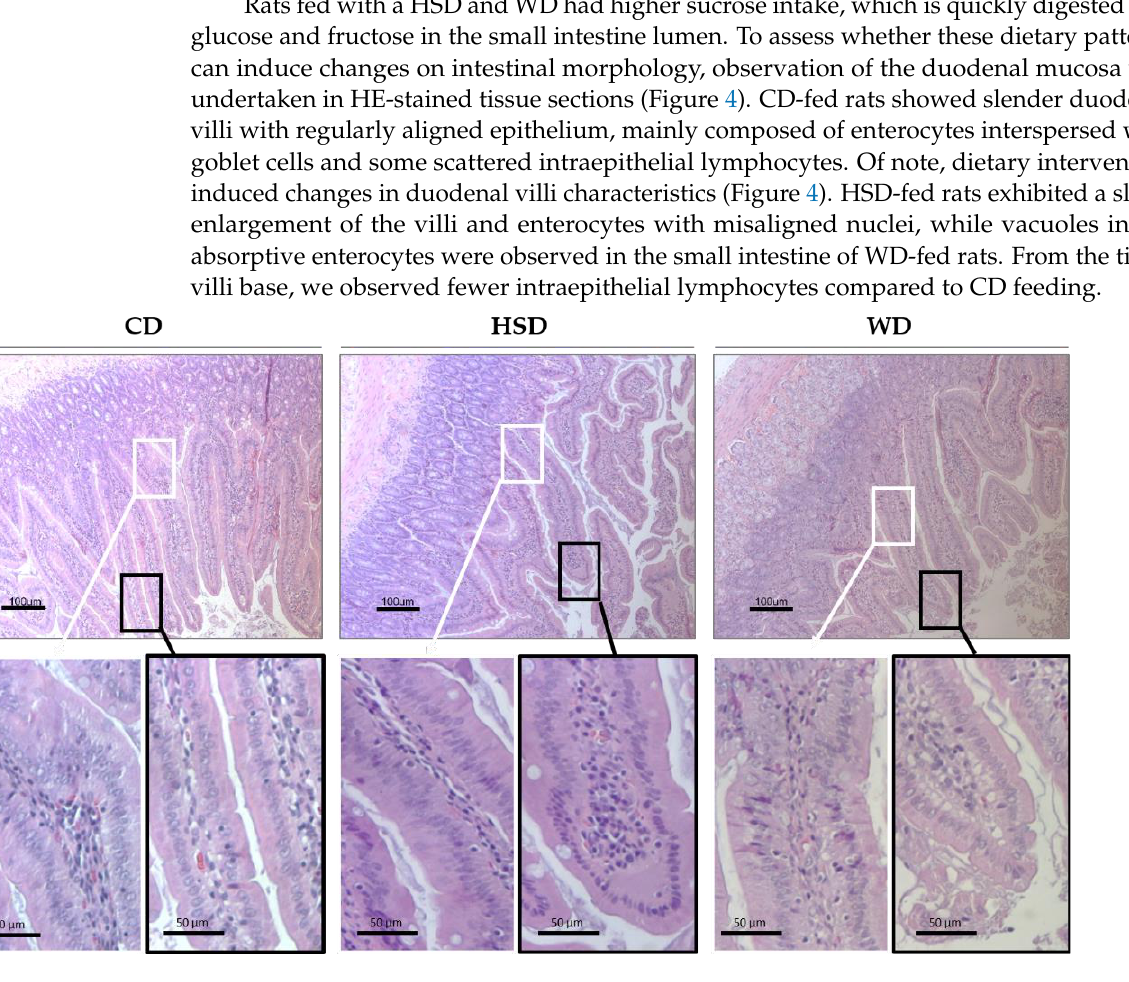
Figure 4. Dietary effects on the small intestine. Representative images of HE-stained duodenum of rats fed with chow diet (CD), high-sugar diet (HSD), and Western diet (WD). The inset shows details of the villi in small intestines, from near the villi base (white box) to the tip (black box). Villi in duodenum from CD-fed rats showed regularly aligned simple columnar epithelium and occasional intraepithelial lymphocytes. HE-staining of tissue sections from HSD-fed rats exhibited enterocytes with misaligned nuclei and slight enlargement of the villus tip. The duodenal villi of HFD-fed rats revealed vacuoles in simple columnar epithelial cells.